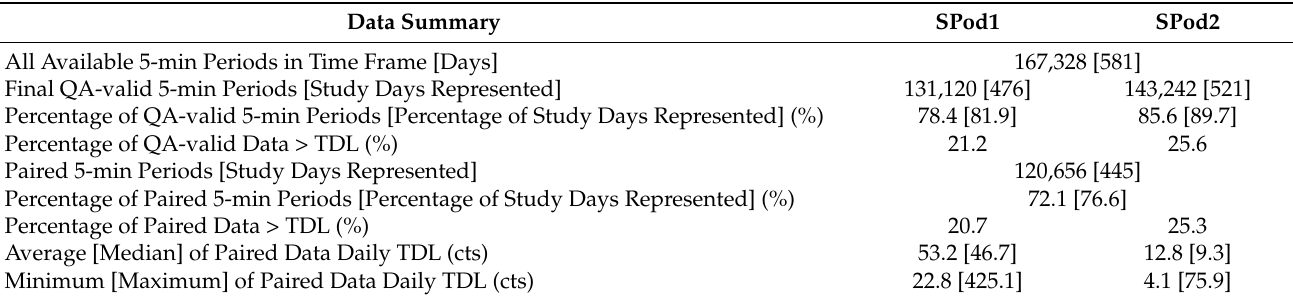
Table 1. Summary of the 5-min SPod Dataset. Data